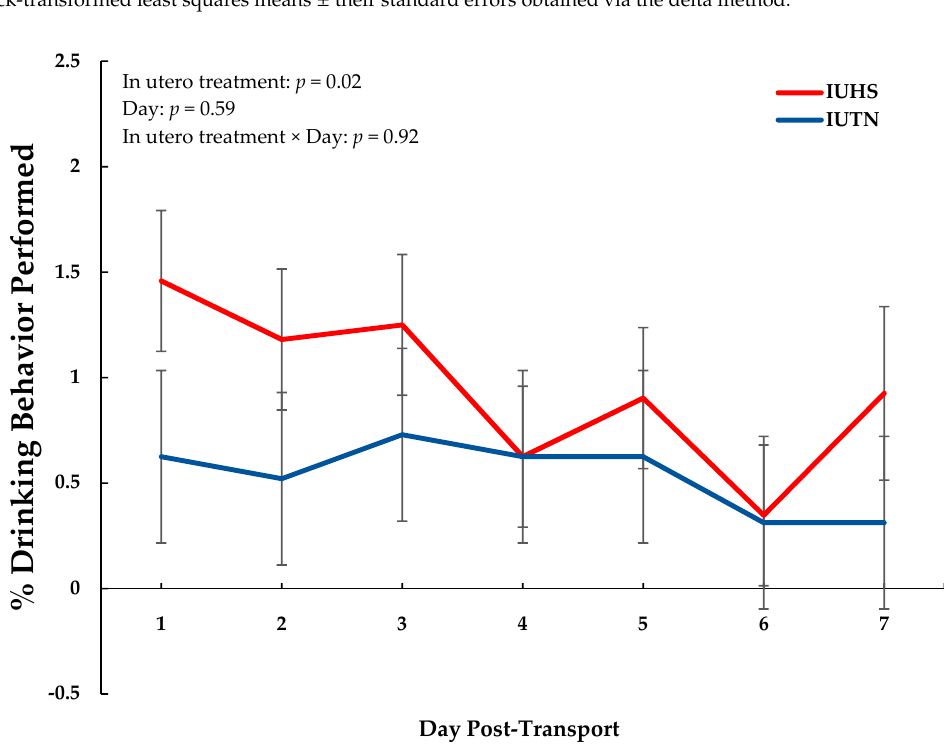
Figure 2. Piglet performance of drinking behavior organized by in utero treatment (thermoneutral (IUTN) and heat stress (IUHS)) over a 7-day period post-transport. Sexual status of the piglets a ff ected the performance of aggressive behavior. Overall, boars spent more time performing aggressive behaviors than barrows (1.01 ± 0.11 and 0.28 ± 0.09%, respectively; F 1,4.9 = 25.2; p = 0.004; data not